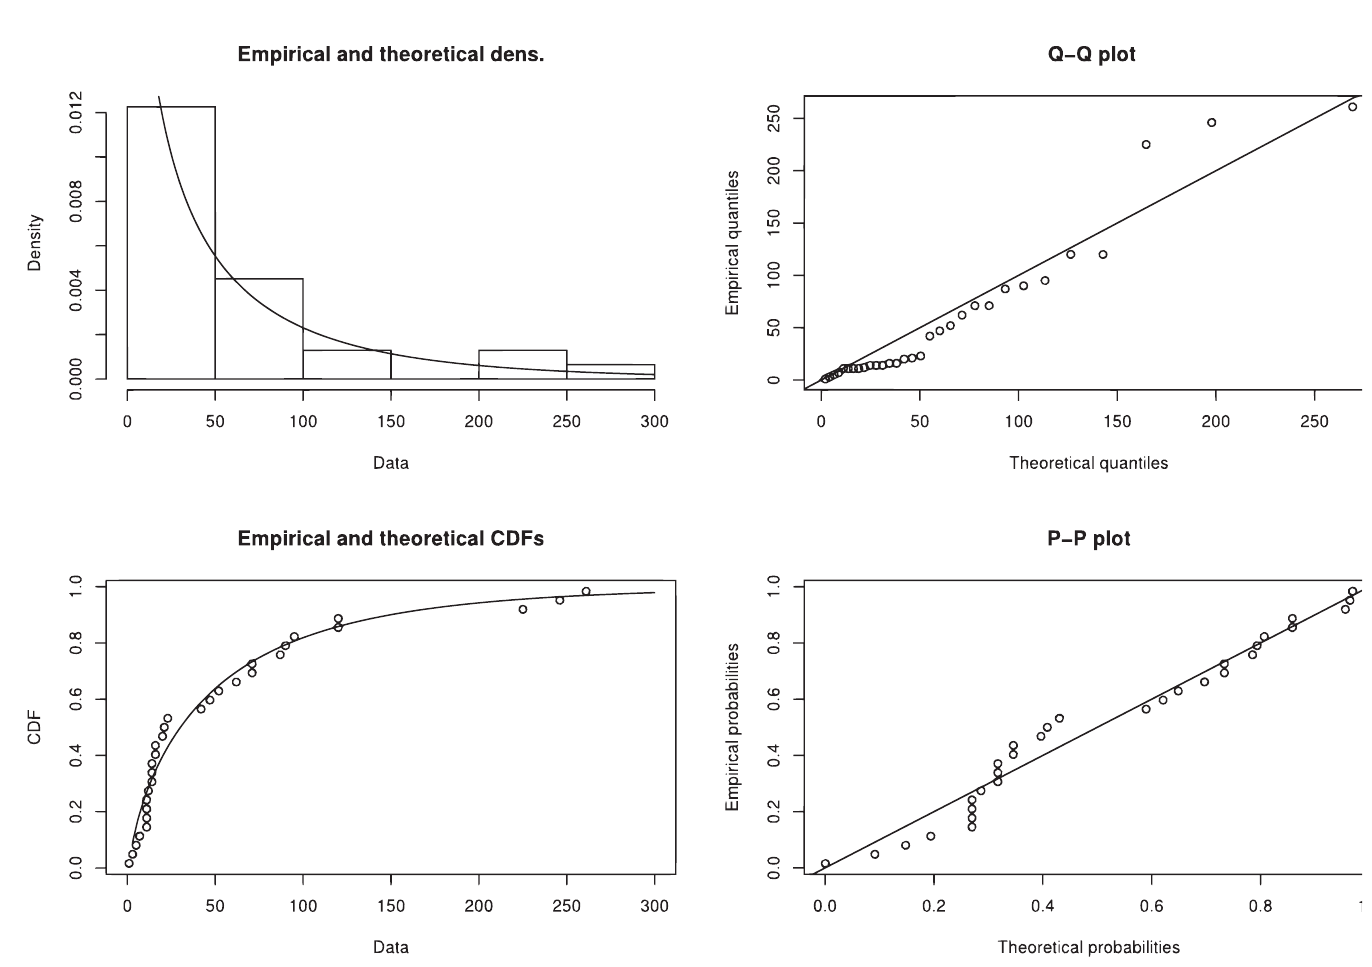
Fig 3. The fitted pdf of W-TEXPD on the histogram of failure times of 31 air conditioning system of airplane along with their cdf, Q-Q and probability plots.